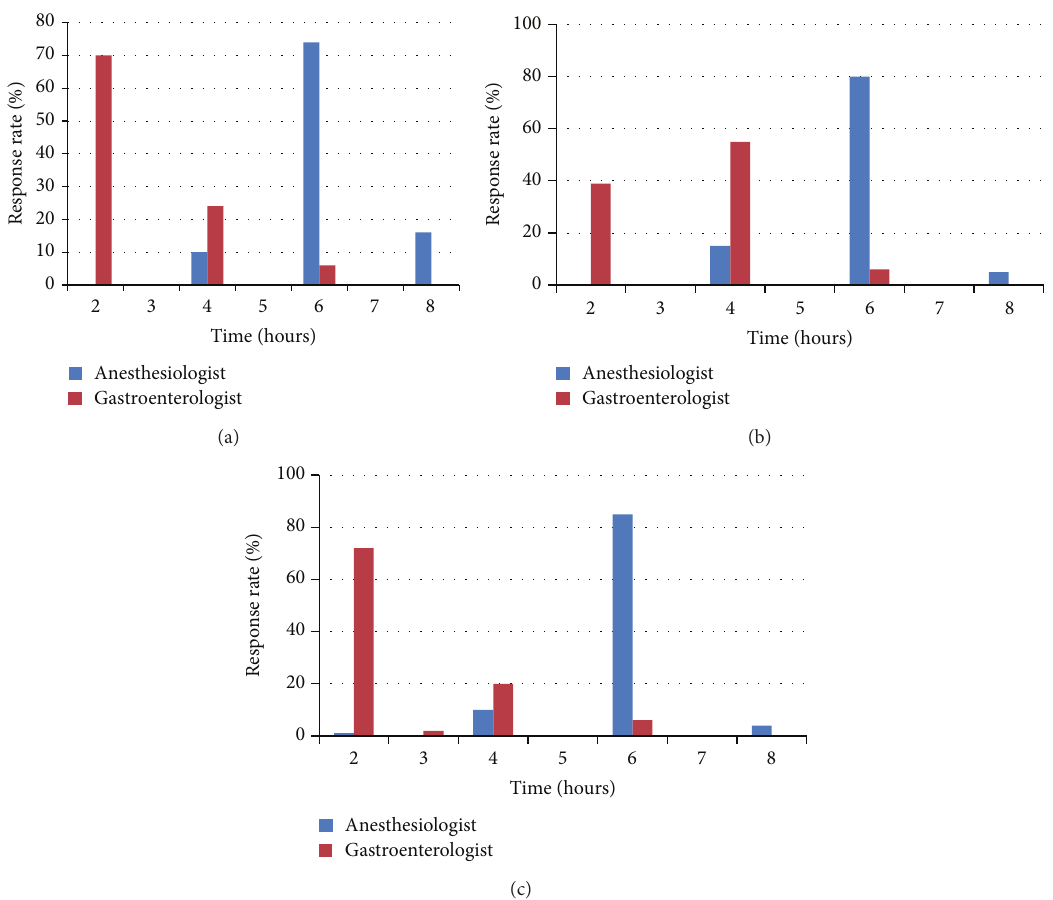
Figure 1: (a) Optimal time interval between last ingestion of bowel preparation and starting endoscopy in diabetics. (b) Optimal time interval between last ingestion of bowel preparation and starting endoscopy in patients with gastroparesis . (c) Optimal time interval between last ingestion of bowel preparation and starting endoscopy in patients with